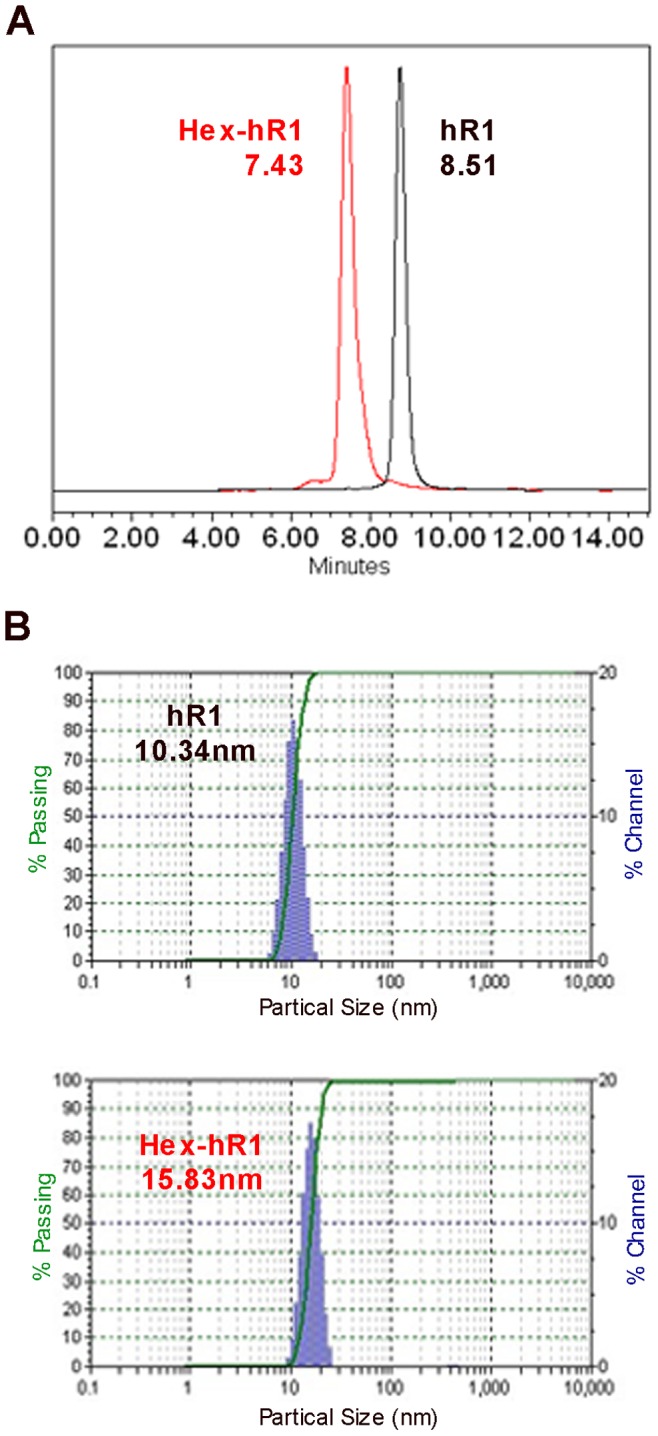
Molecular purity and size of hR1 and Hex-hR1 shown by SE-HPLC (A) and DLS (B).